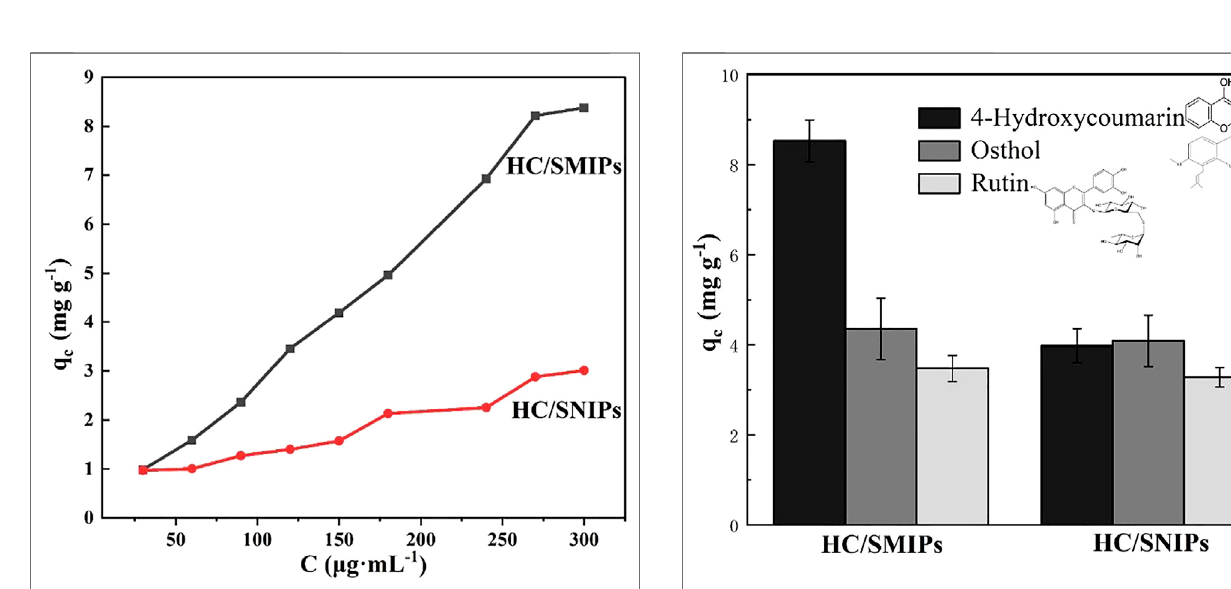
FIGURE 5 | Adsorption isotherm curves for adsorption of HC on HC/ SMIPs and HC/SNIPs.